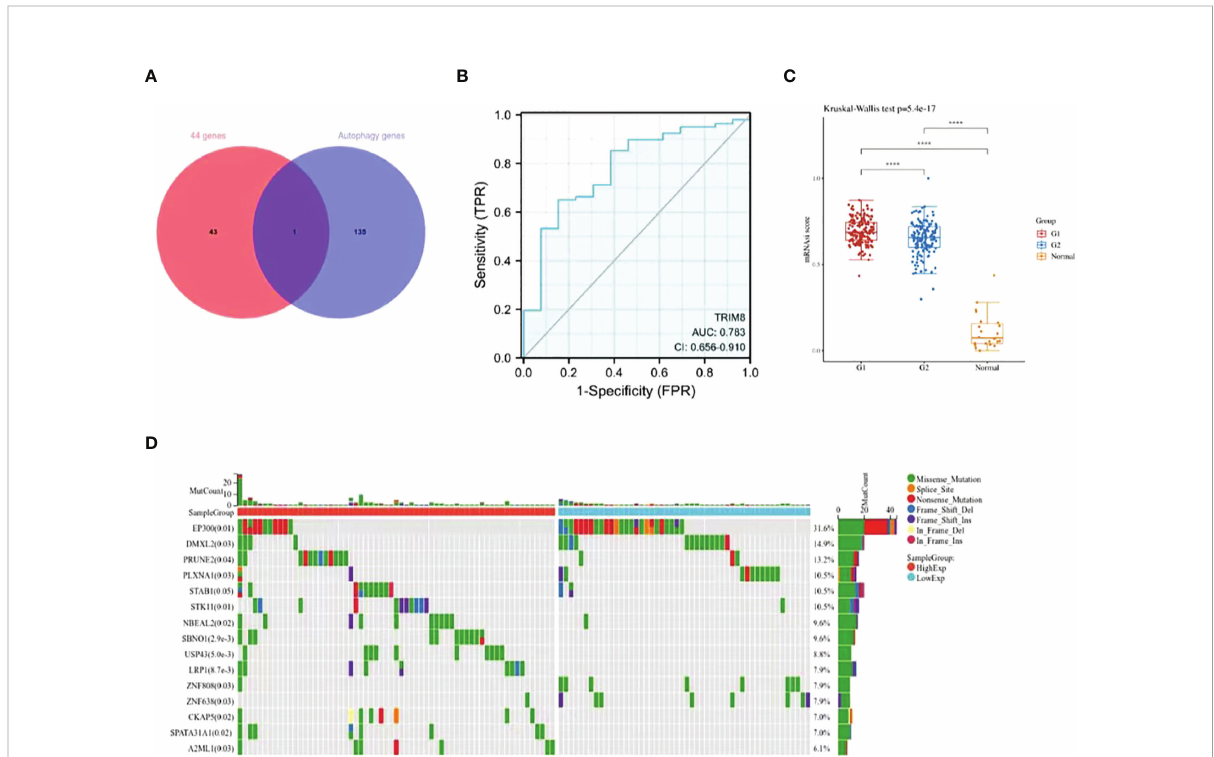
FIGURE 4 Identi fi cation and analysis of TRIM8. (A) The Venn diagram of 44 ubiquitination-related genes and autophagy -related genes. (B) The ROC curve of TCGA-CESC according to the expression of TRIM8. (C) Distribution of CSCs scores in different groups. G1 represents the low expression group of TRIM8, and G2 the high expression group of TRIM8. ****p<0.001. (D) The top 15 mutation genes in high and low TRIM8 expression group,